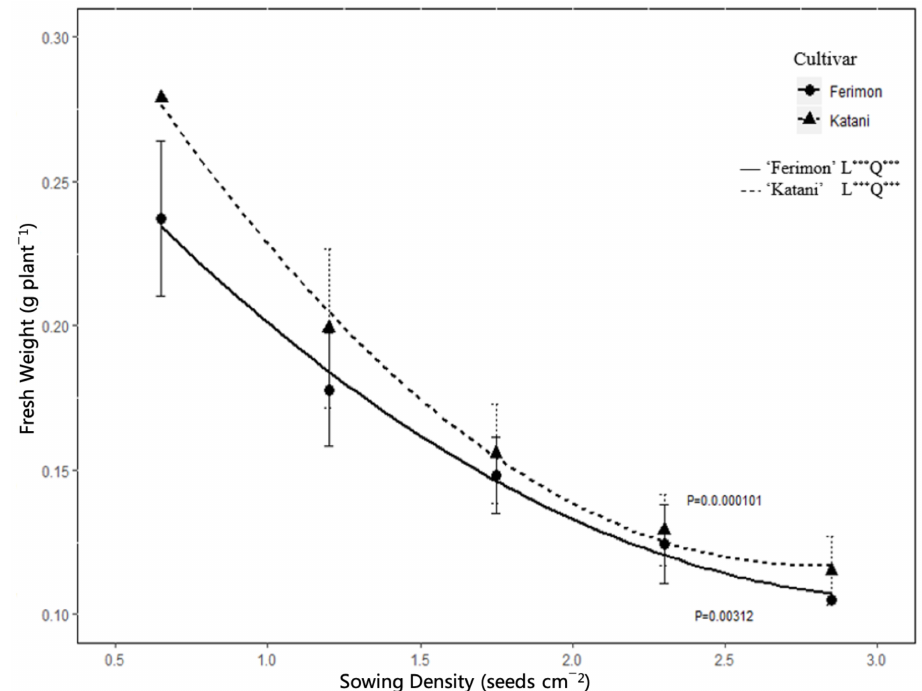
Figure 4. Fresh weight per plant of baby leaf hemp ‘Ferimon’ and ‘Katani’ in response to increasing sowingdensity.Datarepresentmean ± SEof15experimentalunits(3cropcycleseachwith5experimental units per treatment per cultivar). Significance of linear (L) and quadratic (Q) regression represented as ***, significant at p ≤